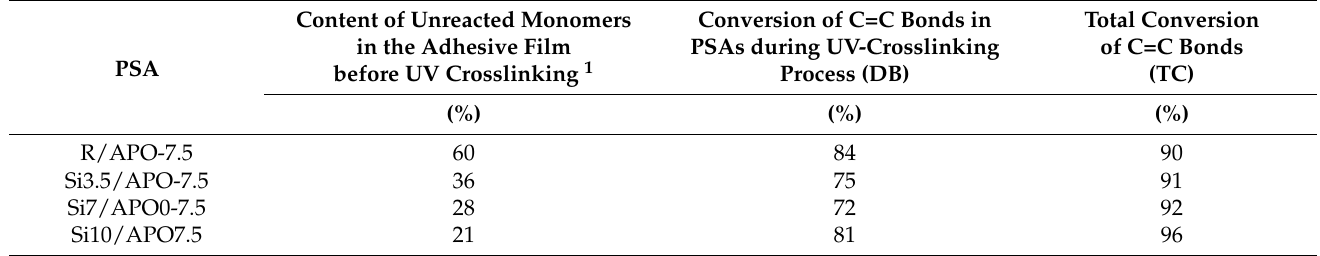
Table 2. Double-bond conversion determined with FT-IR spectroscopy and total monomer conversion.